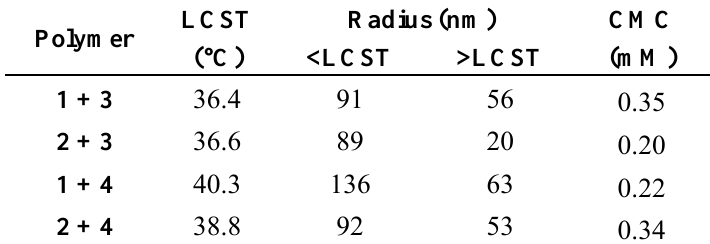
Table 3. Summary of characteristics of the dual component systems